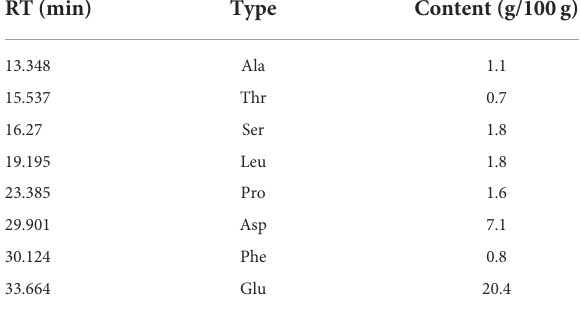
H 2 − 3 − , and H 3 − 4 , indicated that H 1 , H 2 , H 3 , and H 4